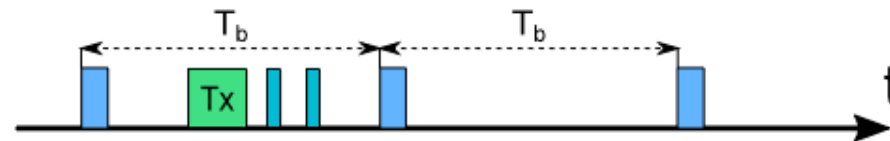
Figure 2. Transmission waveform for Class B node (own source).